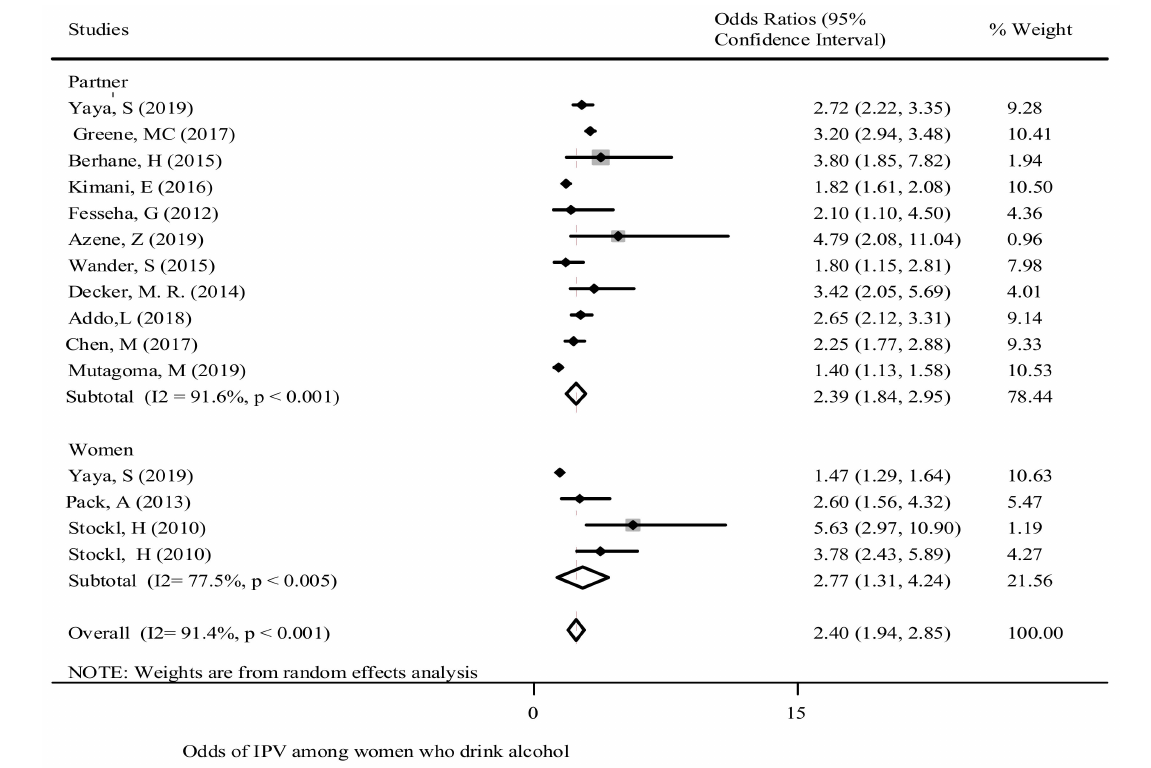
Figure 3. The association of drinking alcohol and experience of reporting GBV in SSA.